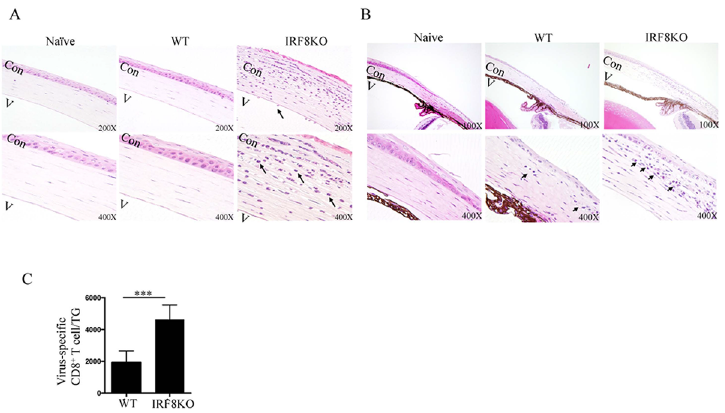
Fig 2. Loss of IRF8 in T cells correlates with ocular inflammation during HSV-1 infection. WT (C57BL/ 6J) or IRF8KO mice were infected with HSV-1. (A & B) Inflammation was determined by histology. For histological analysis, eyes were harvested on day 8 post-infection (p.i.) and sections through the (A) cornea or (B) limbus were stained with hemotoxylin and eosin and depicted inflammatory cellular infiltration (arrows). Na ï ve: na ï ve WT, AC:anterior chamber, Cor: corneal. (C) Trigeminal ganglia (TG) were isolated on day 8 p.i., digested with collagenase and analyzed by flow cytometry. The cells were gated on CD45 and absolute numbers of gB-Tetramer + CD8 + T cells were determined. Statistical analysis of the virus titer was based on analysis of 5 mice per group. Data represent at least 3 independent